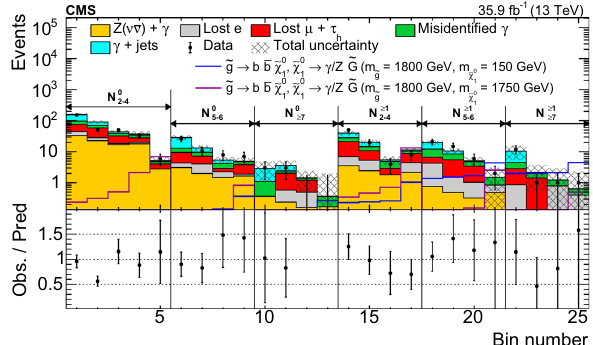
Fig. 4 Observed numbers of events and predicted numbers of events from the various SM backgrounds in the 25 signal regions. The cate- gories, denoted by vertical lines, are labeled as N b number of jets and b refers to the number of b-tagged jets. The num- bered bins within each category are the various p miss in Table 1. The lower panel shows the ratio of the observed events to the predicted SM background events. The error bars in the lower panel are the quadrature sum of the statistical uncertainty in the observed data and the systematic uncertainty in the predicted backgrounds before the adjustments based on a maximum likelihood fit to data assuming no signal